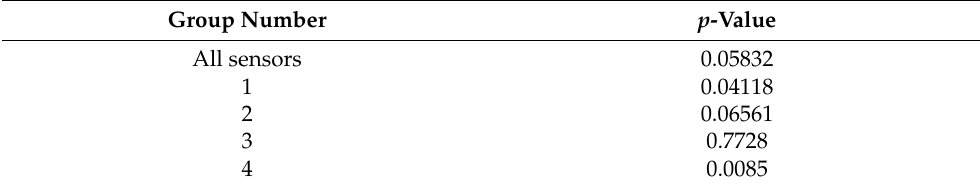
Table 3. Kolmogorov test—Groups of